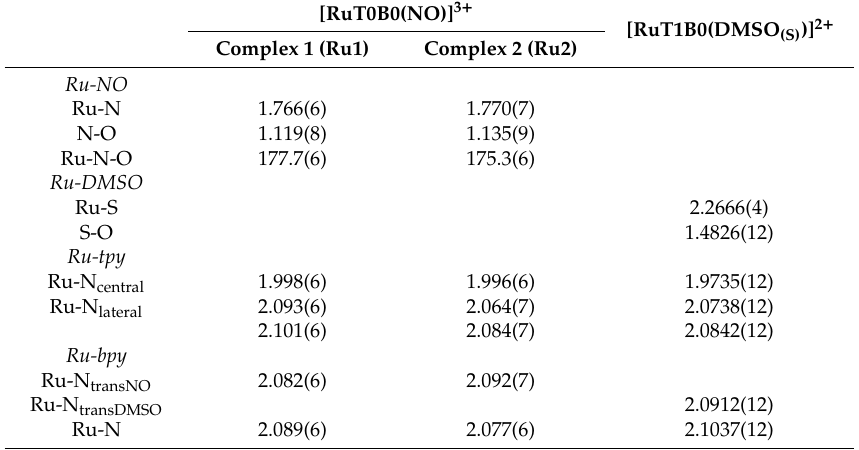
Figure 5. Asymmetric unit for [RuT0B0(NO)](PF 6 ) 3 · 1 drawn at the 50% probability level. Hydrogen atoms are omitted for clarity. Table 4. Selected bond lengths (in Å) and angles (in deg.) in [RuT0B0(NO)] 3 + , and [RuT1B0(DMSO (S) )] 2 +